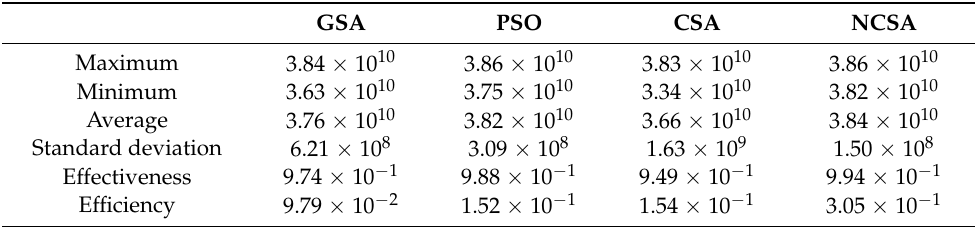
Table 7. Statistical data of applied metaheuristic algorithms on well placement optimization for case study